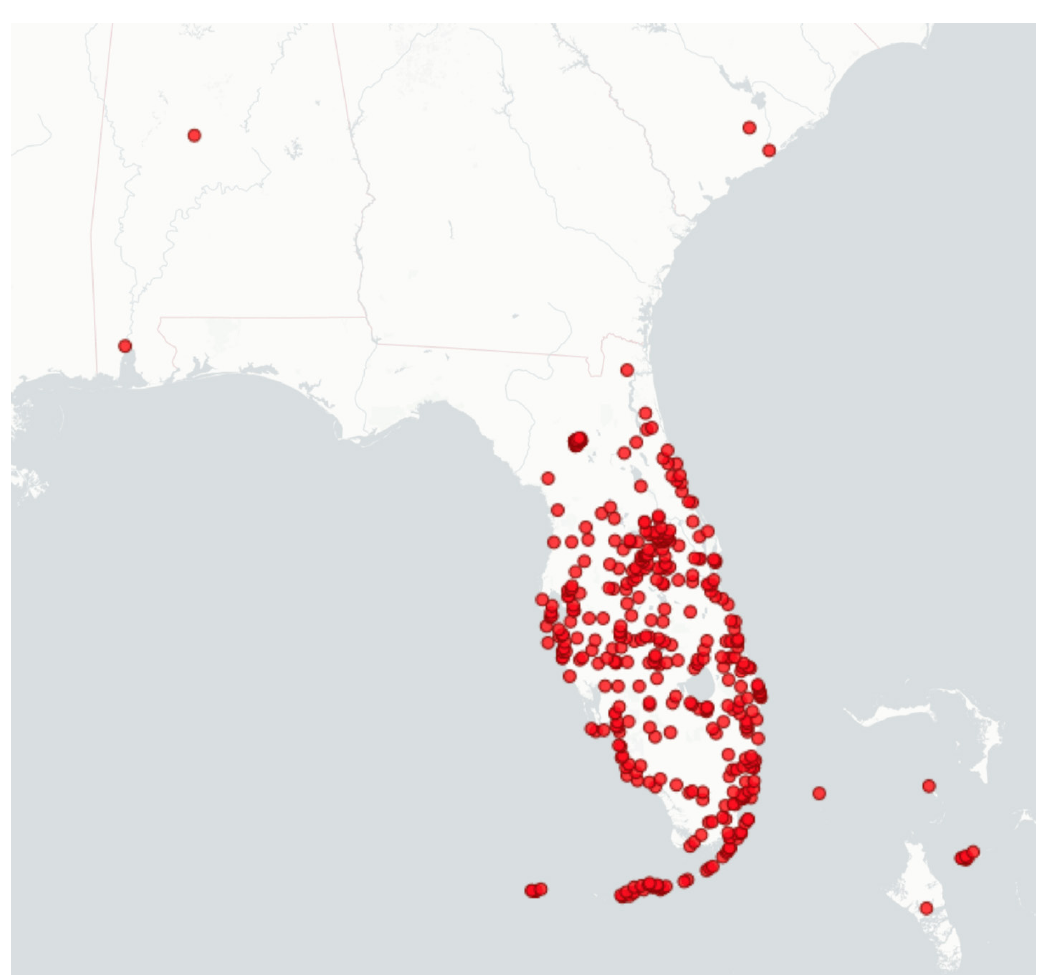
Fig 2. Site records of Nylanderia bourbonica in the southeastern US and the western Bahamas (mapped using